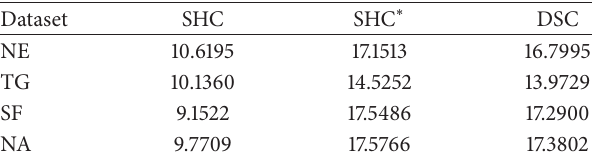
Table 2: Indistinguishability.